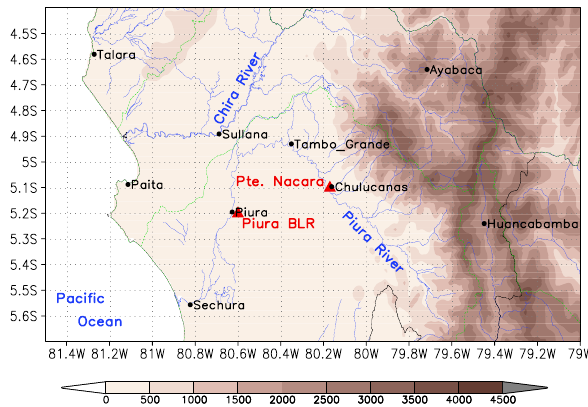
Fig. 1. Map of the region of study. Terrain elevation (m) is shown in shading, rivers are indicated in blue and data locations with red triangles. River basin boundaries are indicated in green.